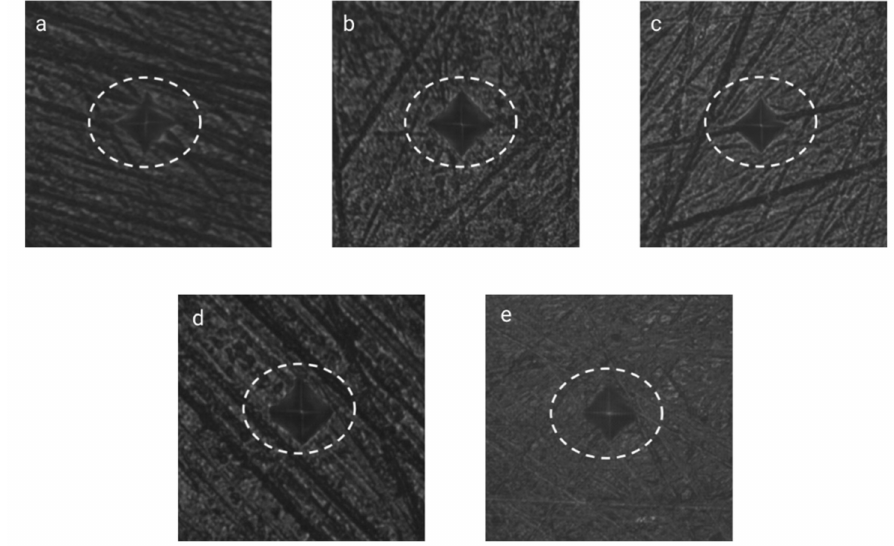
Figure 3. ( a ) Baseline SMH VK indents; ( b ) 6% HP post-treatment SMH VK indents; ( c ) 35% HP post- treatment SMH VK indents; ( d ) 35% CP post-treatment SMH VK indents; ( e ) PAP+